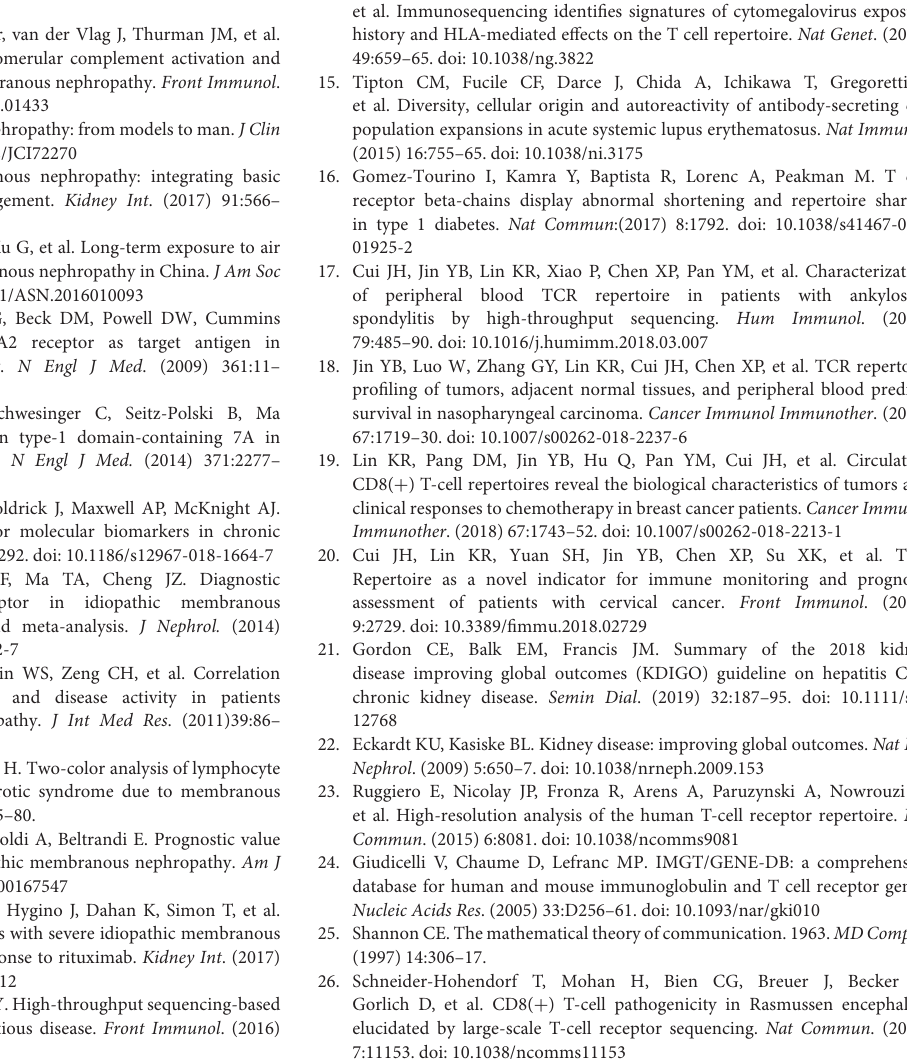
Figure S1 | Comparison of the age (A) and gender (B) between healthy controls and MN patients. Figure S2 | No significant correlation between the diversity and clinical characteristics. ns, no significant. Table S1 | Clinical and sequencing information of the patients. Table S2 | The V and J genes usage in the blood